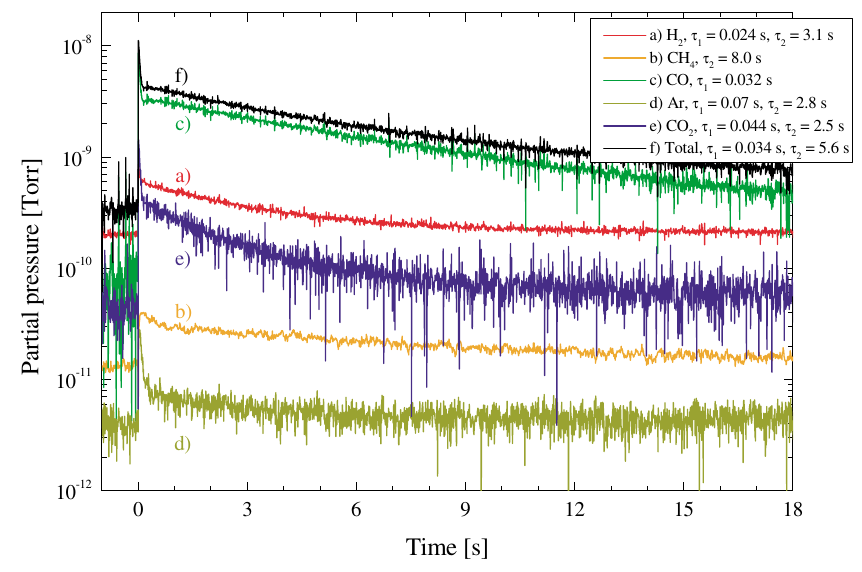
FIG. 5. (Color) Partial pressures measured for chamber A with 1 : 5 (cid:2) 10 9 incident Pb 53 (cid:1) ions at 89.2 (cid:7) grazing incidence. The decay times shown in the legend result from two exponential is the result from the fit to the fast part of the decay. fits to the pressure decays. (cid:5) 1